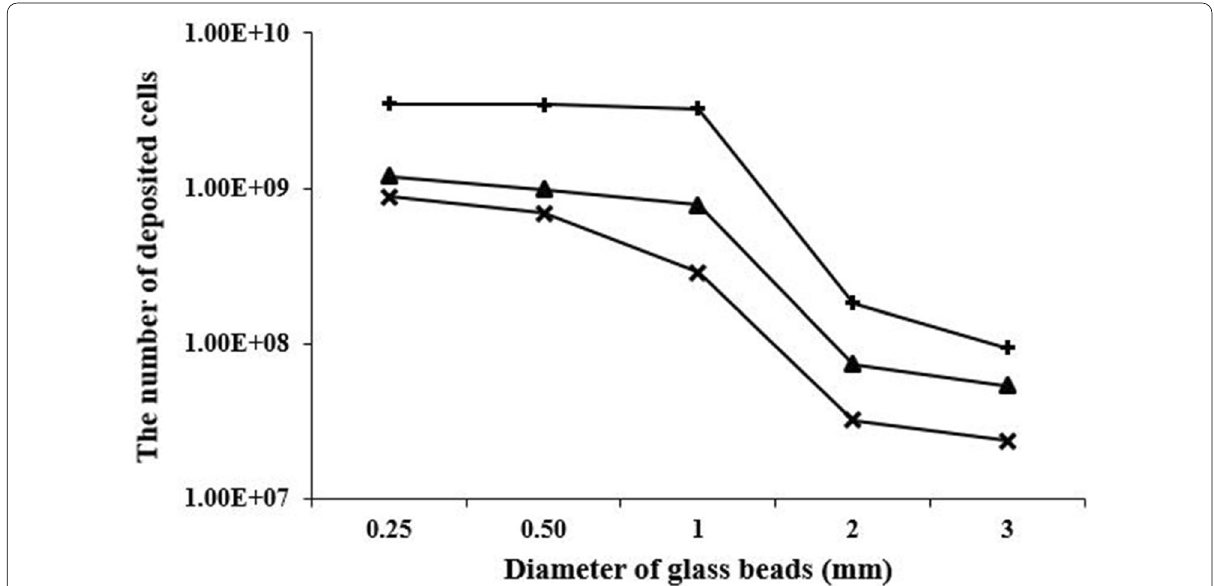
Fig. 3 The number of cells deposited into the columns packed with different diameter of glass beads for OD 600 0.15 (cross sign), OD 600 0.75 (closed triangle), OD 600 2.25 (plus